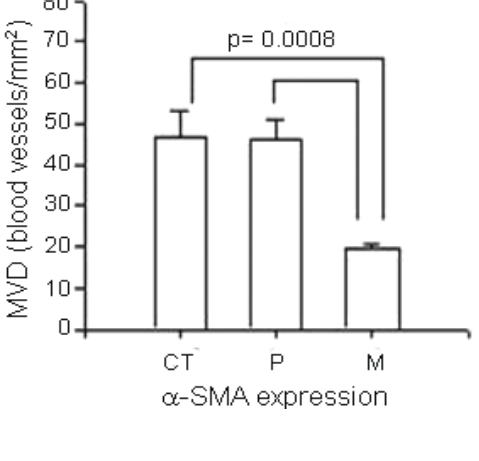
Figure 4. Microvascular density as a function of (cid:2) -SMA expression in periendothelial cells from different regions of GITC. Data are presented as mean (cid:4) SEM (differences between center of the tumor, periphery and metastasis regions: *p <